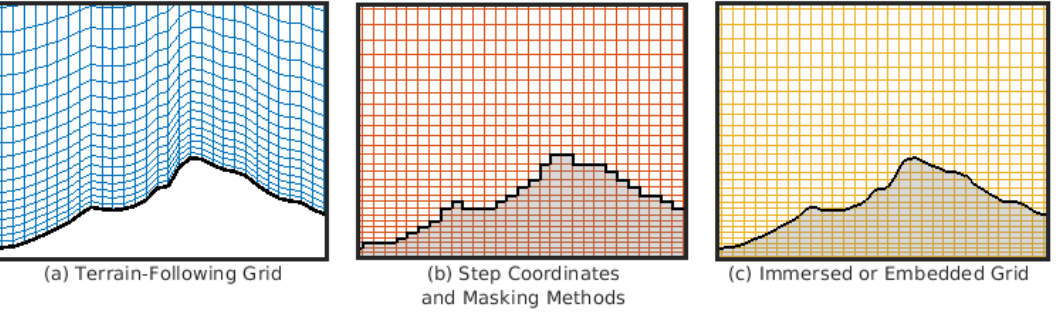
Figure 13. Three grids are shown, focusing on the details of a mountain peak. A subset of a terrain-following grid is shown in ( a ). Two alternatives are also shown: ( b ) step (eta) coordinates or masking methods; and ( c ) immersed or embedded